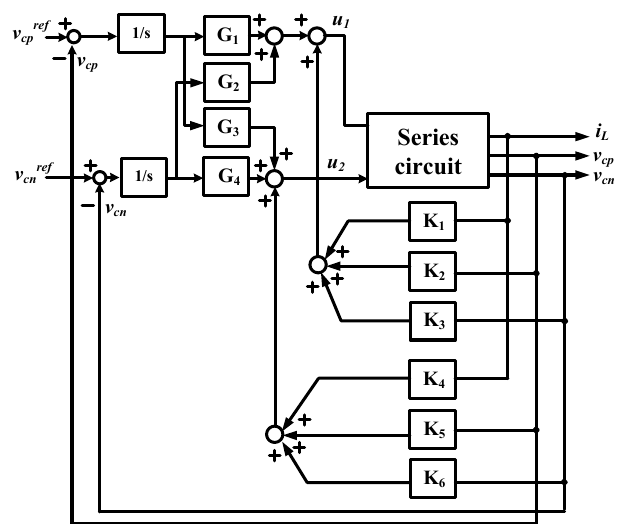
Figure 8. Configuration of series circuit with LQR.